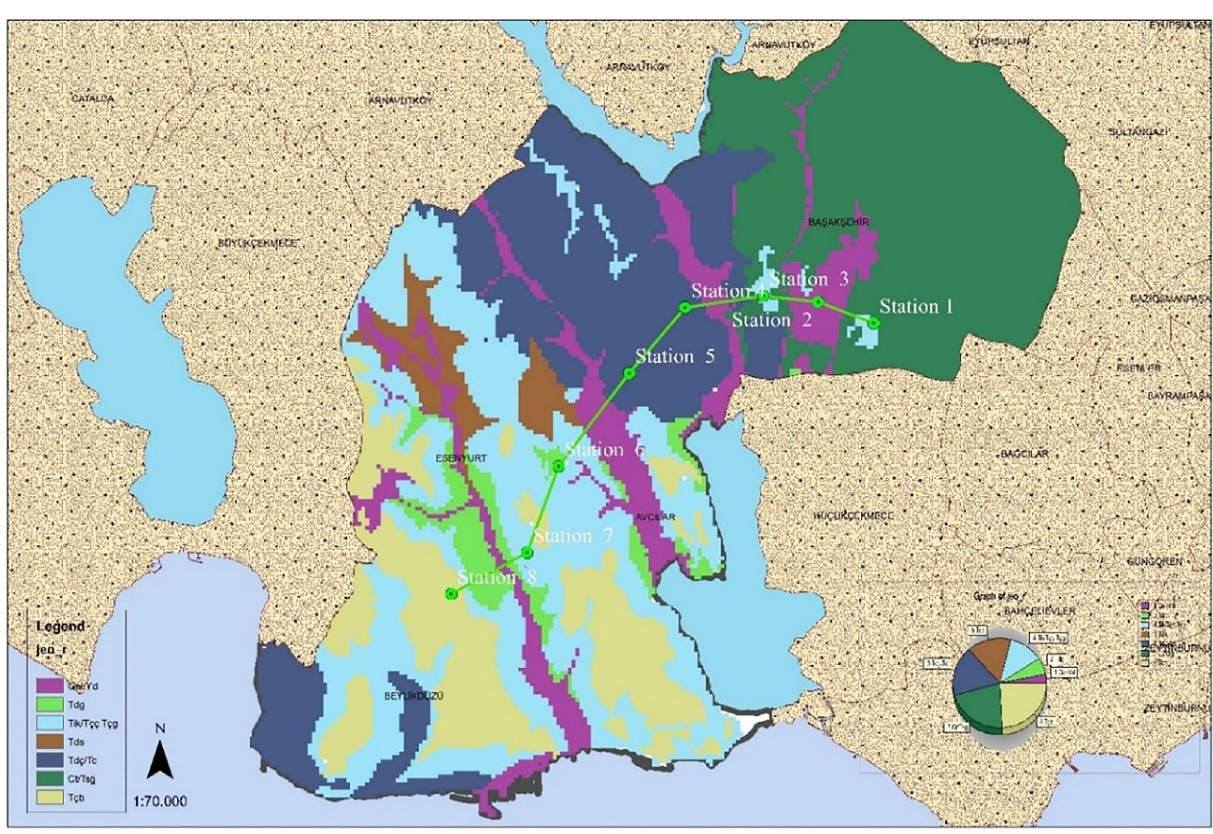
Fig. 2 Geological map of the study area (illustrated by